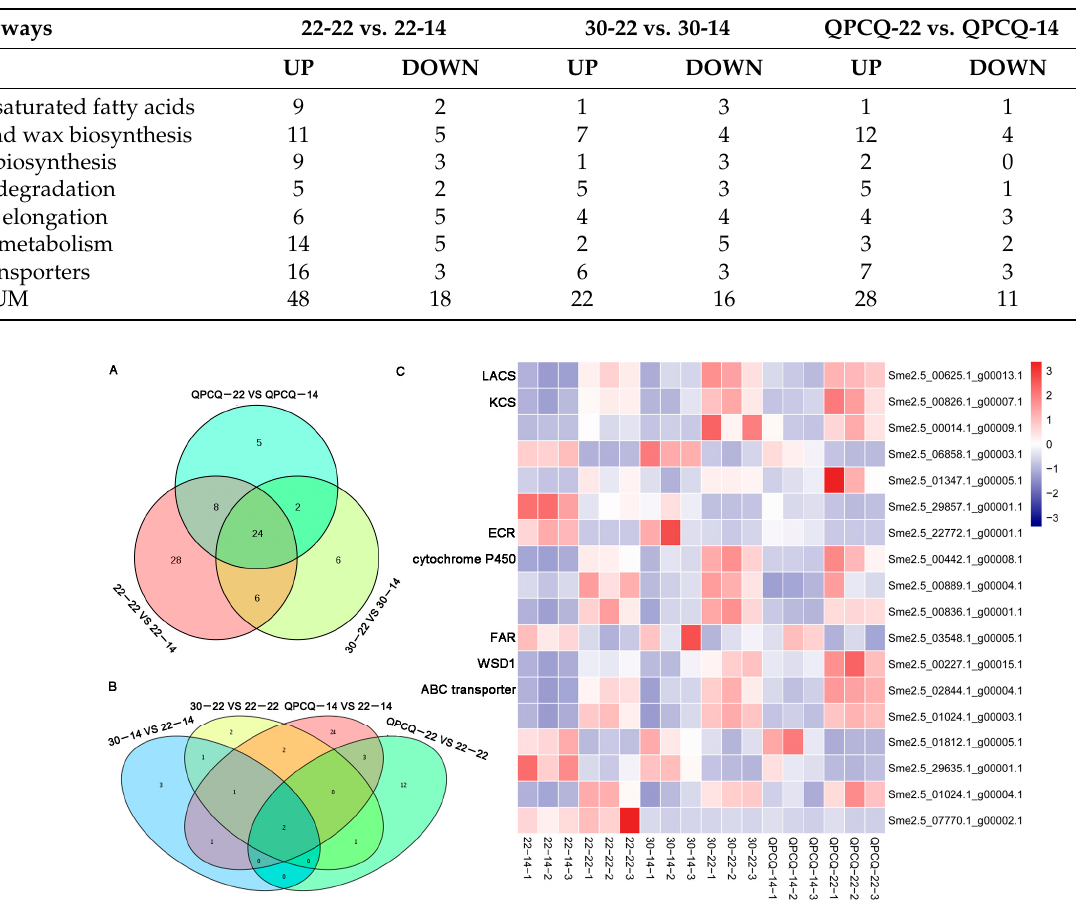
Table 2. The number of pathways related to cutin and wax in groups 22 DAP vs. 14 DAP.